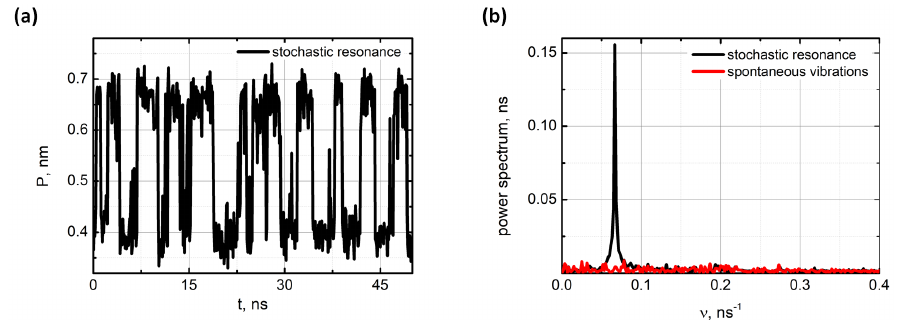
Figure 5. Stochastic resonance of the oligo-PF-7 induced by an oscillating field E = E 0 cos ( 2 πν t ) = E 0 cos ( 2 π t / T ) : ( a ) The dynamic trajectory at D = 1.03nm, T = 13ns and E = 0.2Vnm − 1 . ( b ) Power spectrum of spontaneous vibrations (red curve) and stochastic resonance (black